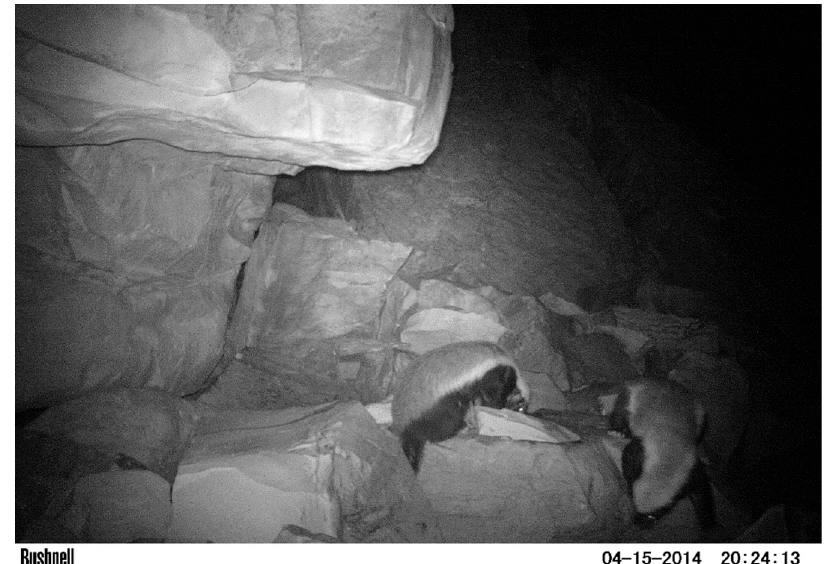
Figure 2. A picture of the first honey badgers taken by a camera-trap in our study, showing the typical micro-habitat where this species shelters in the study area. The entrance of the den (not visible in the picture) was located just to the left of the left-most individual.